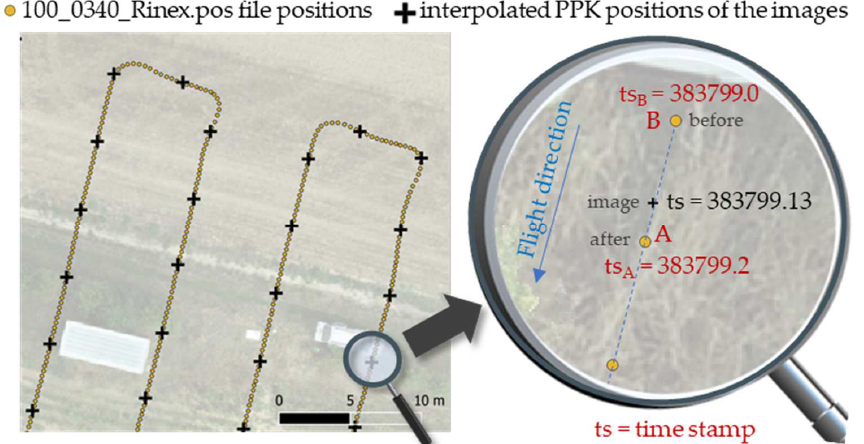
Figure 16. Image position interpolation from Rinex observations. The two positions immediately before (B) and after (A) image capture were selected based on the time stamp. The trajectory was considered to be linear between two successive Rinex positions. The coefficient was used to determine the proximity of the image to the “before” and “after” point and was then used as a weighting coefficient for the calculation of the image latitude, longitude, and elevation from the two ppk positions.